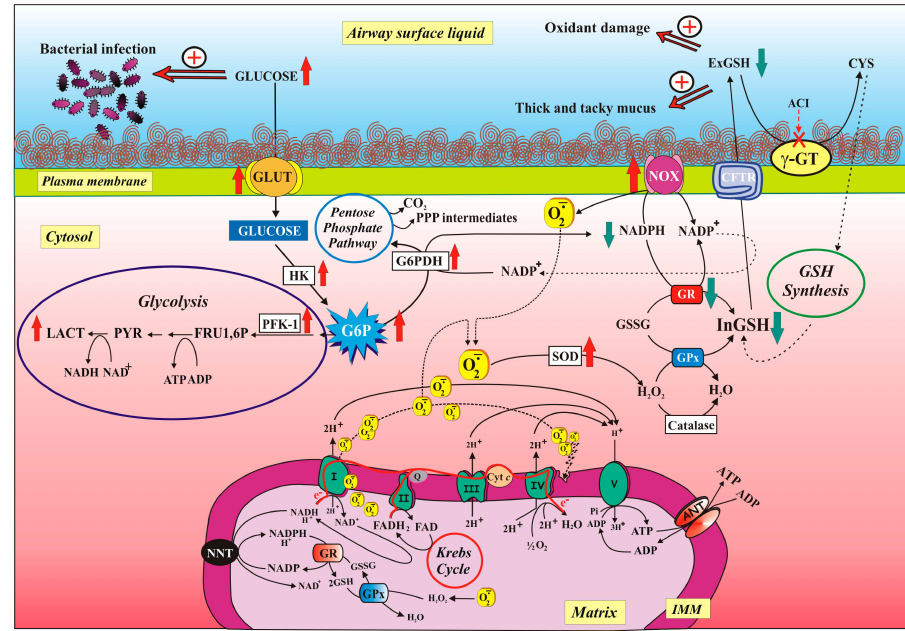
Figure 2. An overview of both the GSH turnover and the principal glucose related metabolic pathways: modulation of ROS and glucose levels in airway surface liquid and fight oxidative stress in cystic fibrosis cells. Main abbreviations: ACI, Acivicin; ANT, adenine nucleotide translocator; CYS; Cysteine; CI, Complex I or NADH-ubiquinone oxidoreductase; II, Complex II or succinate-ubiquinone oxidoreductase; III, Complex III or ubiquinone–cytochrome-c oxidoreductase; IV, Complex IV or cytochrome-c oxidase; V, Complex V or FoF1 ATP synthase; GLUT, Glucose Transporter / s; G6P, Glucose-6-phosphate; G6PDH, glucose-6-phosphate dehydrogenase; exGSH, extracellular GSH; inGSH, intracellular GSH; GPx, glutathione peroxidase; GR, glutathione reductase; GSSG, oxidized glutathione; γ GT, γ -glutamyltransferase; HK, Hexokinase; H 2 O 2 , hydrogen peroxide; IMS, intermembrane mitochondrialspace; MIM,mitochondrialinnermembrane; NOX,NAD(P)Hoxidases; O 2 −• , Superoxide anion; OMM, outer mitochondrial membrane; PPP, pentose phosphate pathway; ROS, reactive oxygen species; SOD, Superoxide